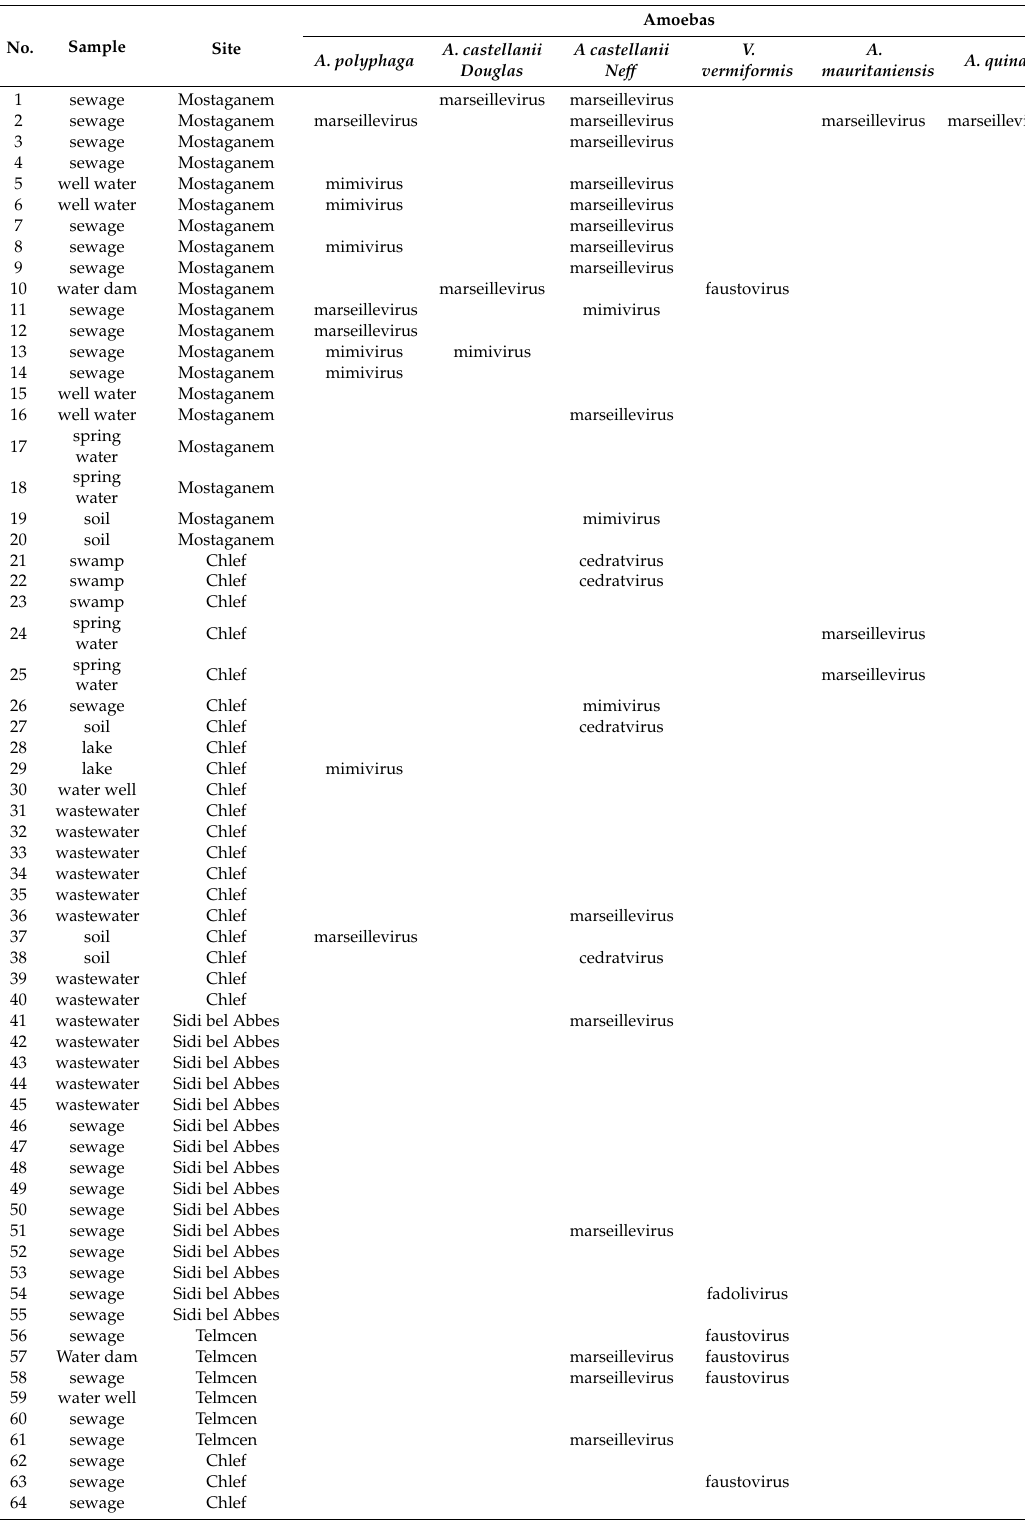
Table 1. Distribution of giant virus isolates with their relative amoeba and samples.